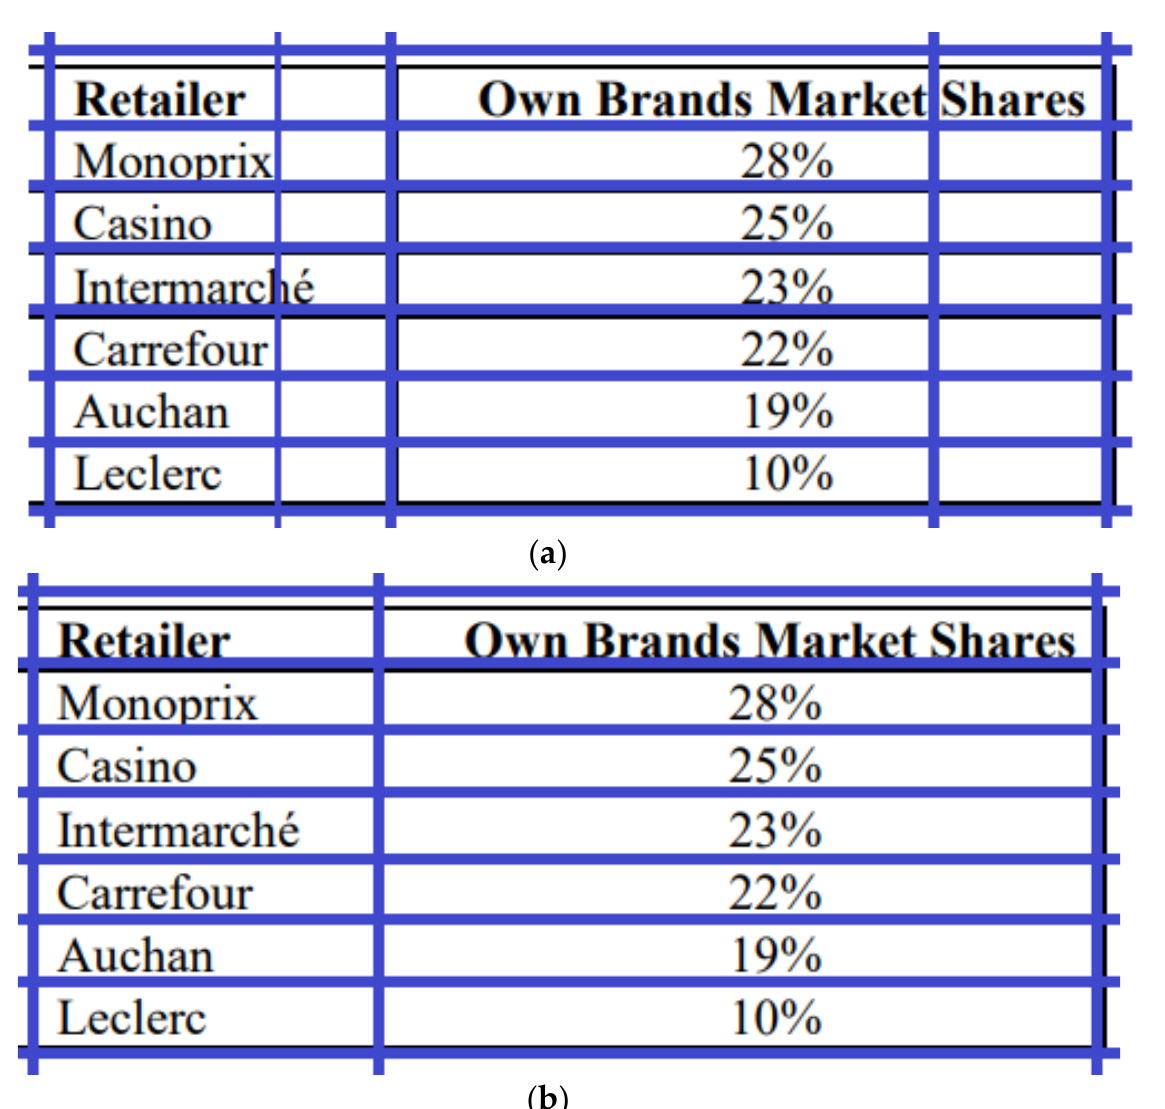
Figure 9. Prediction results visualization: ( a ) test form image; ( b ) line segmentation mask prediction map; ( c ) column segmentation mask prediction map; ( d ) visualization of the results.